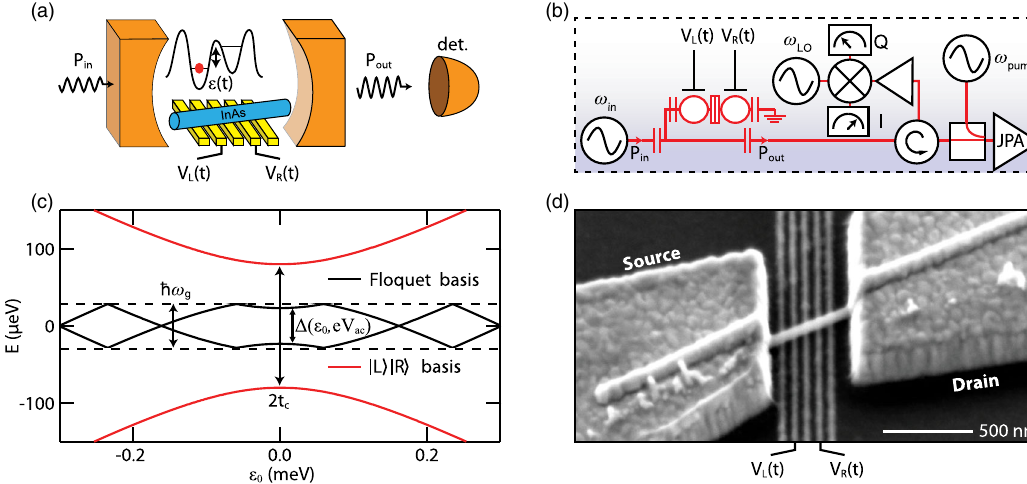
FIG. 1. (a) Driven double quantum dot photon source. The gain medium consists of a DQD whose energy level detuning ϵ ð t Þ is driven periodically. A cavity containing the DQD is probed using a weak input signal with power P P is incident on a detector. (b) Circuit diagram illustrating the DQD, cavity, and linear amplification chain. (c) DQD energy level out diagram, with the bonding and antibonding charge states shown in red. Interdot tunnel coupling results in a level splitting of 2 t ϵ 0 . In the Floquet basis the energy level spectrum is defined only modulo ℏ ω 0 ¼ of the folded levels is Δ ð ϵ 0 ; eV . (d) Scanning electron microscope image of the sample. A single InAs nanowire is placed across five ac Þ bottom gates and electrically contacted by source and drain electrodes. The detuning parameter is driven by applying oscillating voltages V t Þ and V t Þ to two of the L ð R ð